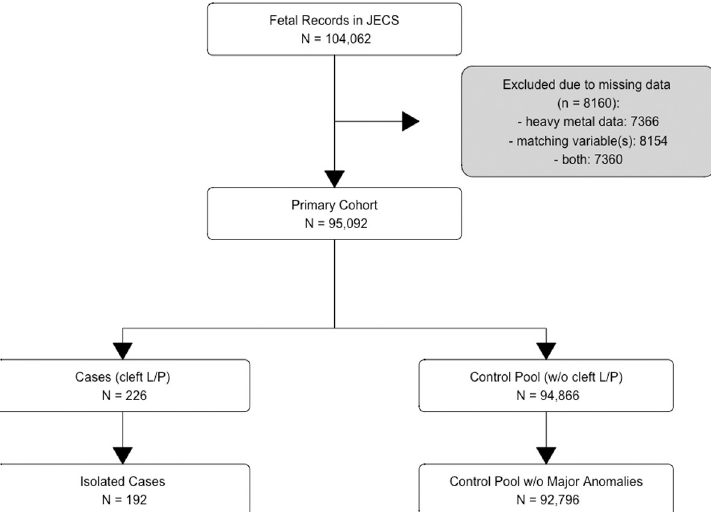
Fig 1. Flow diagram of study cohort. Note: Only matching variables of continuous data were excluded (e.g., maternal age).